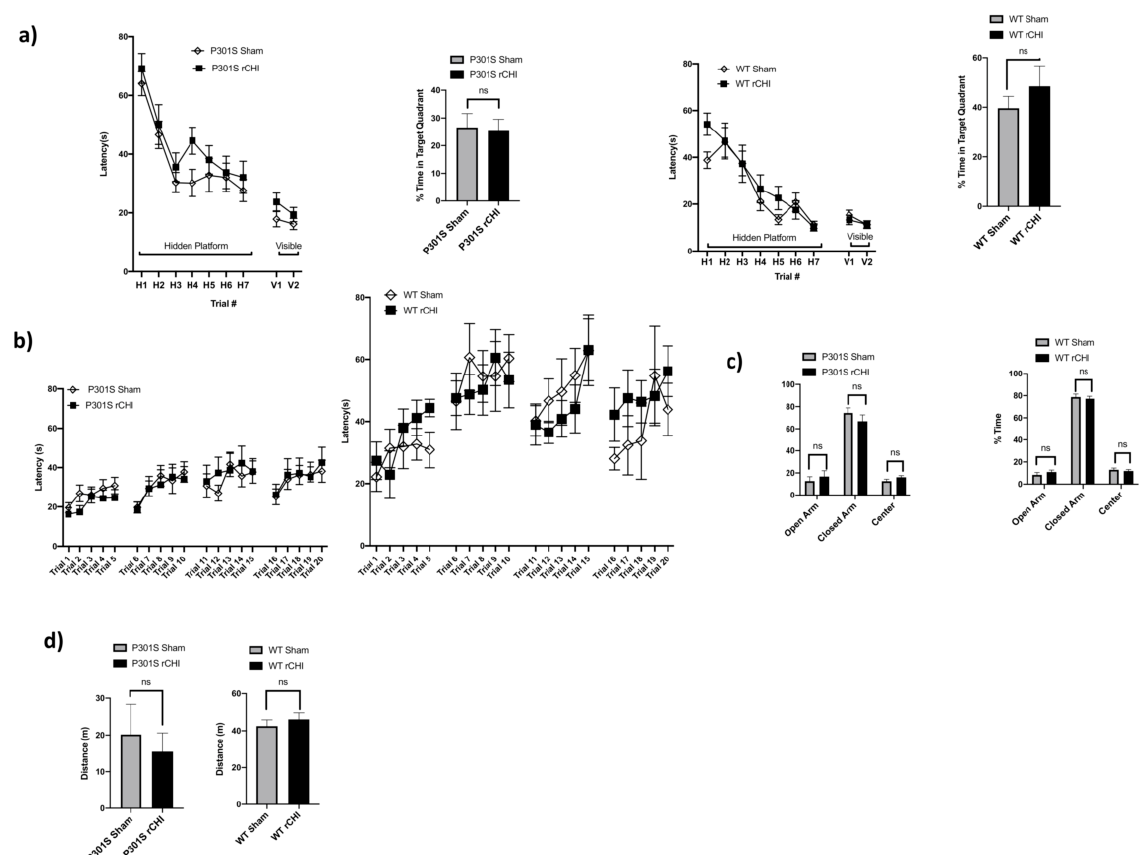
Figure 4. No behavioral deficits were detected 40 days after repetitive closed-head injury (rCHI) in adolescent P301S and WT mice. ( a ) There was no significant difference in Morris water maze (MWM) and Probe trial testing between rCHI vs. sham P301S mice ( n = 14/group, p = 0.16, p = 0.87 respectively) or rCHI vs. sham WT mice ( n = 6/group, p = 0.61, p = 0.38 respectively). ( b ) There were no differences in the rotarod testing between rCHI vs. sham P301S mice ( n = 14/group, p = 0.95), or rCHI vs. sham WT mice ( n = 6/group, p = 0.88). ( c ) There were no differences in the % time spent in the open, closed, and center arm of the plus maze between rCHI vs. sham P301S mice ( n = 14/group, p = 0.53, 0.32, and 0.15, respectively), or rCHI vs. sham WT mice ( n = 6/group, p = 0.38, 0.68, 0.62, respectively). ( d ) No differences were observed in open-field tests among rCHI vs. sham P301S mice ( n = 10/group, p = 0.63, or rCHI vs. sham WT mice ( n = 6/group, p = 0.48). Statistical significance is denoted as follows: ns (non-significant) p > 0.05. Data are mean ± SEM. SEM, standard error of the